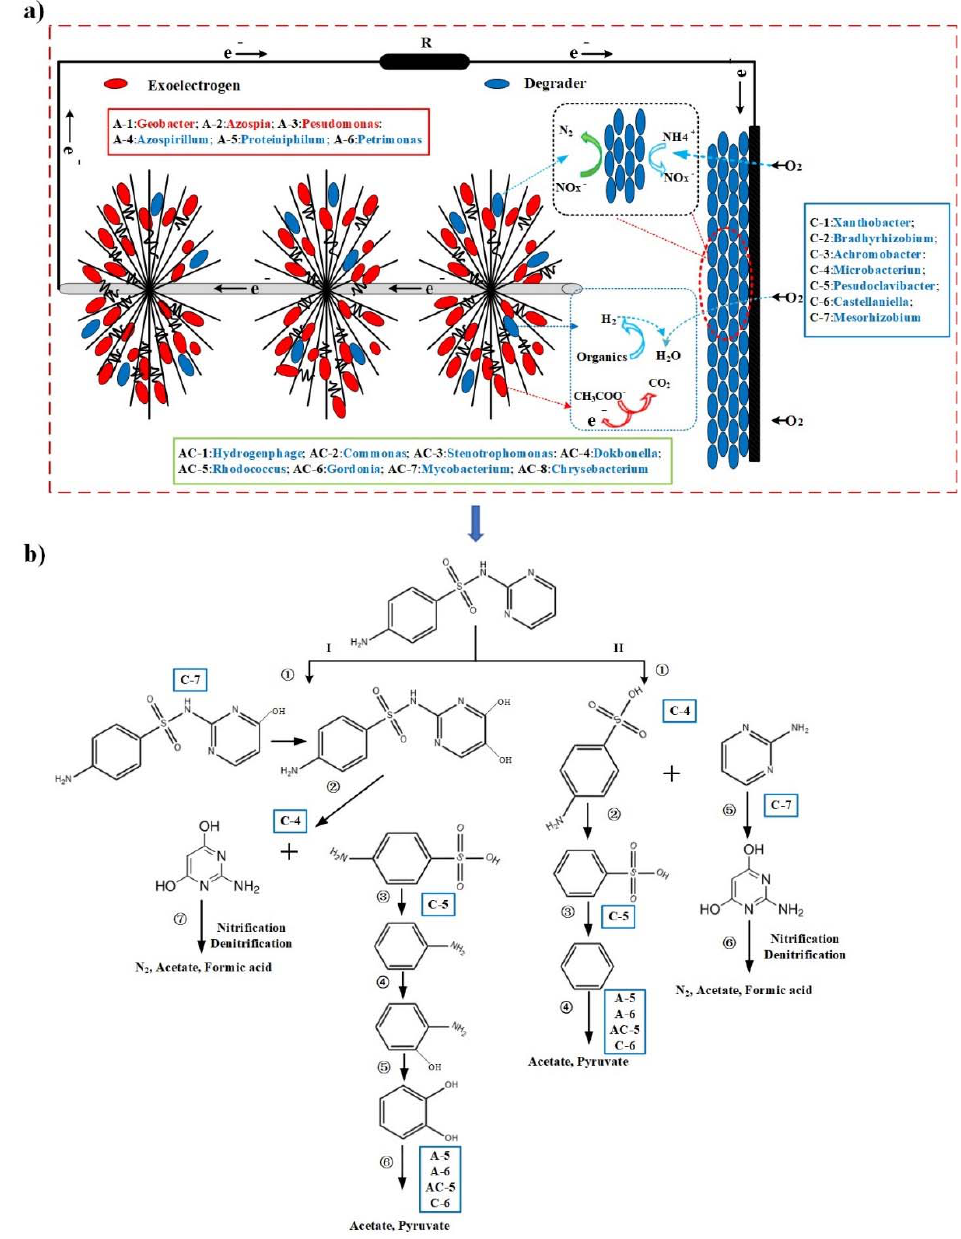
Figure 5. ( a ) Ecological model of SDZ biodegradation in air-cathode MFCs; ( b ) Scheme of potential degradation mechanisms [6,42,51]. (A-n: the genus mainly accumulated in the anode; C-n: the genus mainly clustered in the cathode; AC-n: the genus clustered both in the anode and cathode; I and II: Possible SDZ biodegradation pathway).